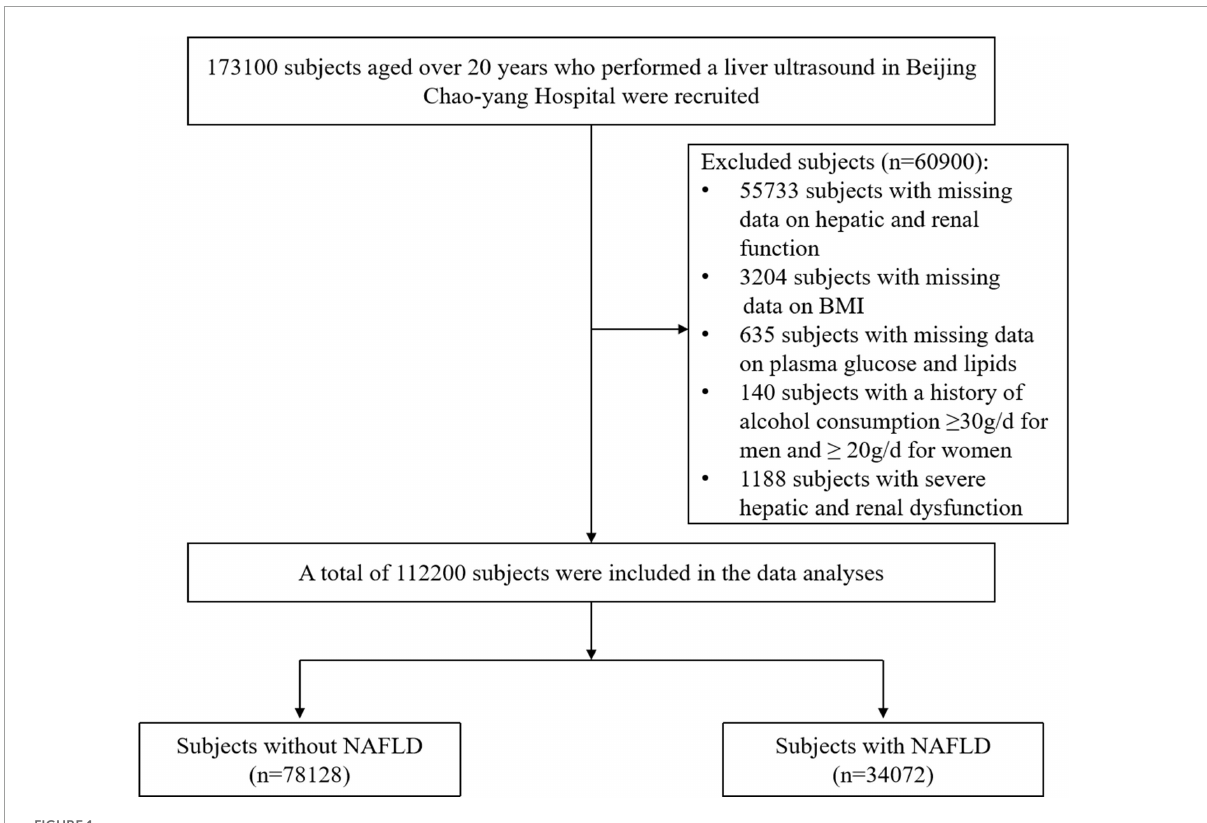
FIGURE1 Flowchart of the cross-sectional study. BMI, body mass index; NAFLD, non-alcoholic fatty liver